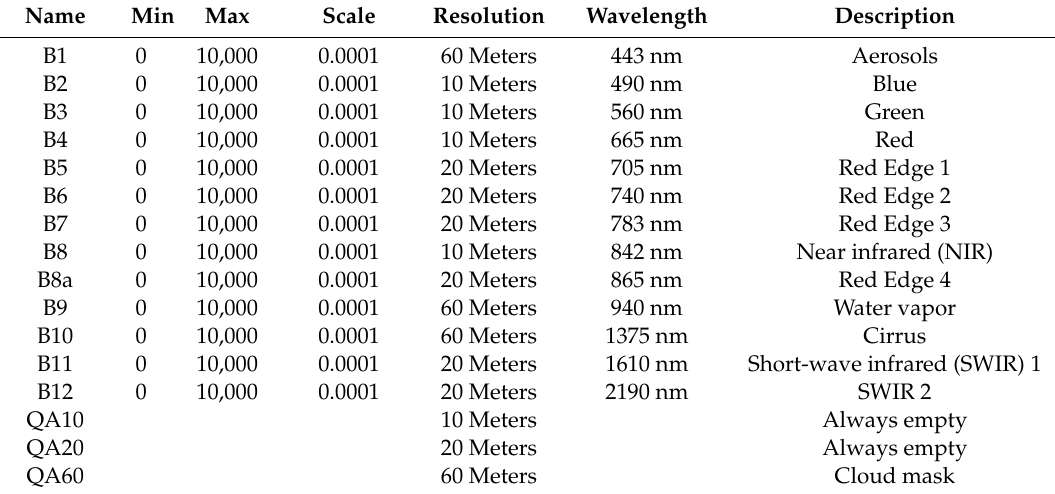
Table 1. Basic characteristics of Sentinel 2 multi-spectral instrument (MSI).